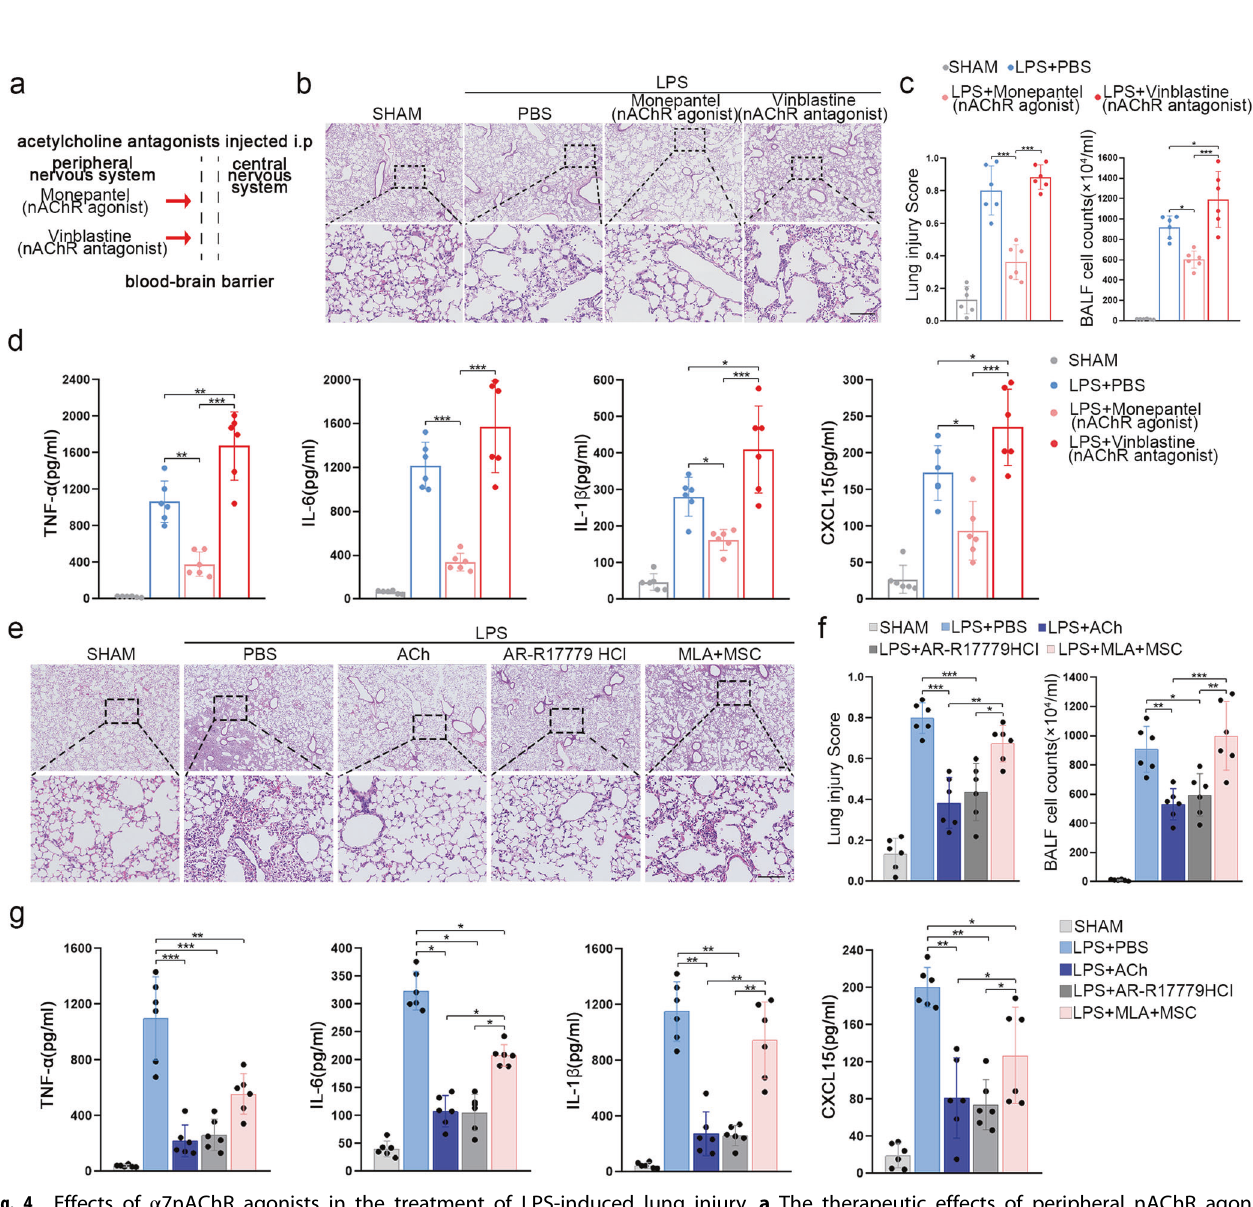
Fig. 4 Effects of α 7nAChR agonists in the treatment of LPS-induced lung injury. a The therapeutic effects of peripheral nAChR agonist monepantel and the peripheral nAChR antagonist vinblastine in acute lung injury were investigated. b Representative H&E staining was performed on lung samples from each group. Photographs of at least 6 sections of each tissue sample were taken. Scale bars, 100 μ m. c The degree of lung injury was calculated and quantitatively analyzed according to the results of H&E staining, and the in fi ltration of leukocytes into BALF was compared among the groups; n = 6. d CXCL15, IL-1 β , TNF- α , IL-6 ELISA kits were used to determine BALF in fl ammatory concentrations; n = 6. e Representative H&E staining was performed on lung samples from each group. Photographs of at least 6 sections of each tissue sample were taken. Scale bars, 100 μ m. f The degree of lung injury was calculated and quantitatively analyzed according to the results of H&E staining, and the in fi ltration of leukocytes into BALF was compared among the groups; n = 6. g CXCL15, IL-1 β , TNF- α , IL-6 ELISA kits were used to determine BALF in fl ammatory concentrations; n = 6